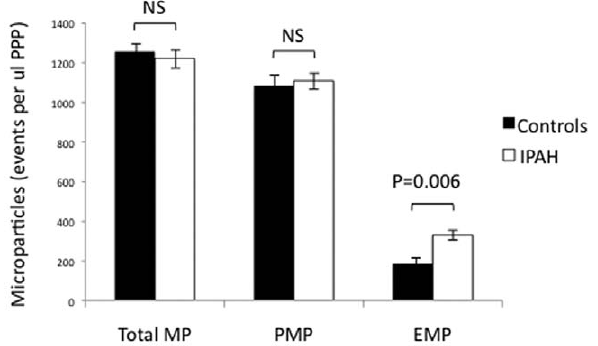
Figure 2. Quantification of circulating microparticles in healthy controls compared to IPAH patients. No difference was found in total microparticle (annexin V + ) or platelet microparticle (CD31 + CD42b + ) levels. Patients with IPAH had a statistically significant increase in circulating endothelial microparticle (CD31 + CD42b 2 ) levels compared to controls. Results expressed as flow cytometric events per ul of platelet poor plasma (PPP) and presented as mean 6 SEM. NA = not significant, MP = microparticles, PMP = platelet microparticles, EMP = endothelial microparticles.